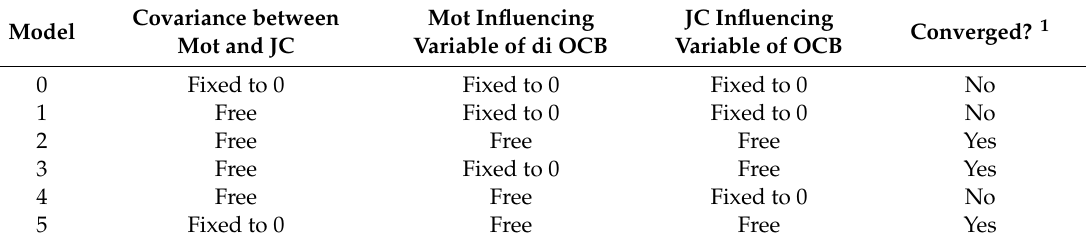
Table 4. Structure of the adapted